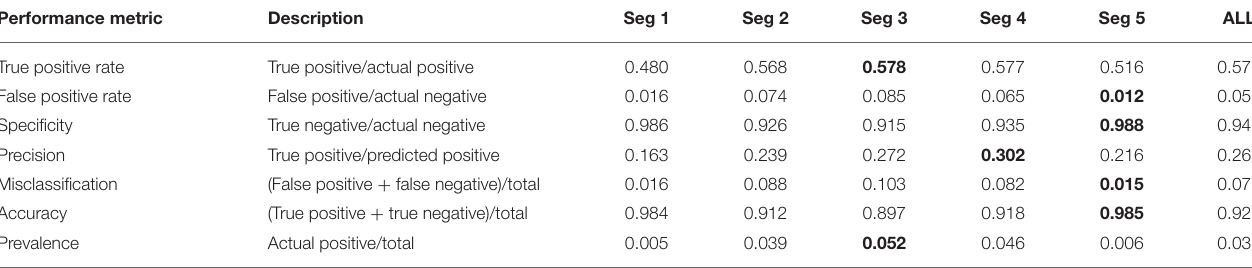
TABLE 2 | Performance metrics from confusion matrices of PrCA DSA (used in DSA transmissions) and PrCA archival (from high-resolution archives) detections. Performance metric